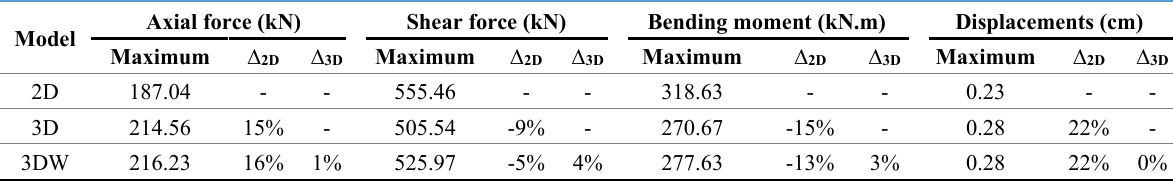
Table 10. Maximum forces and displacements in the support beam of Wall